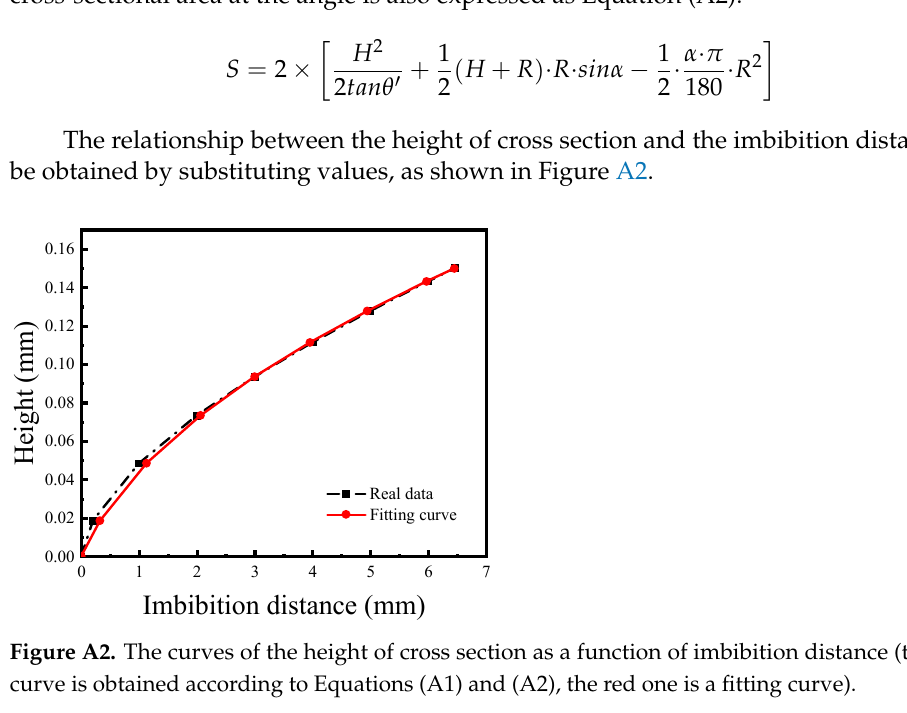
13 of 15 Figure A1. Schematic diagram of the cross section. Due to the difference between imbibition of liquid-displacing-air and that of water- displacing-oil, the displacement resistance of kerosene-displacing-air is far less than that of water-displacing-oil, so that the outer kerosene is evenly distributed at the angle which named region 1 in a very short time. And then, kerosene is displaced out of the single channel, and reversely imbibed along the angle at region 2. The area of region 1 is equal to the area of region 2. Assuming the imbibition distance inside the single channel is L , the